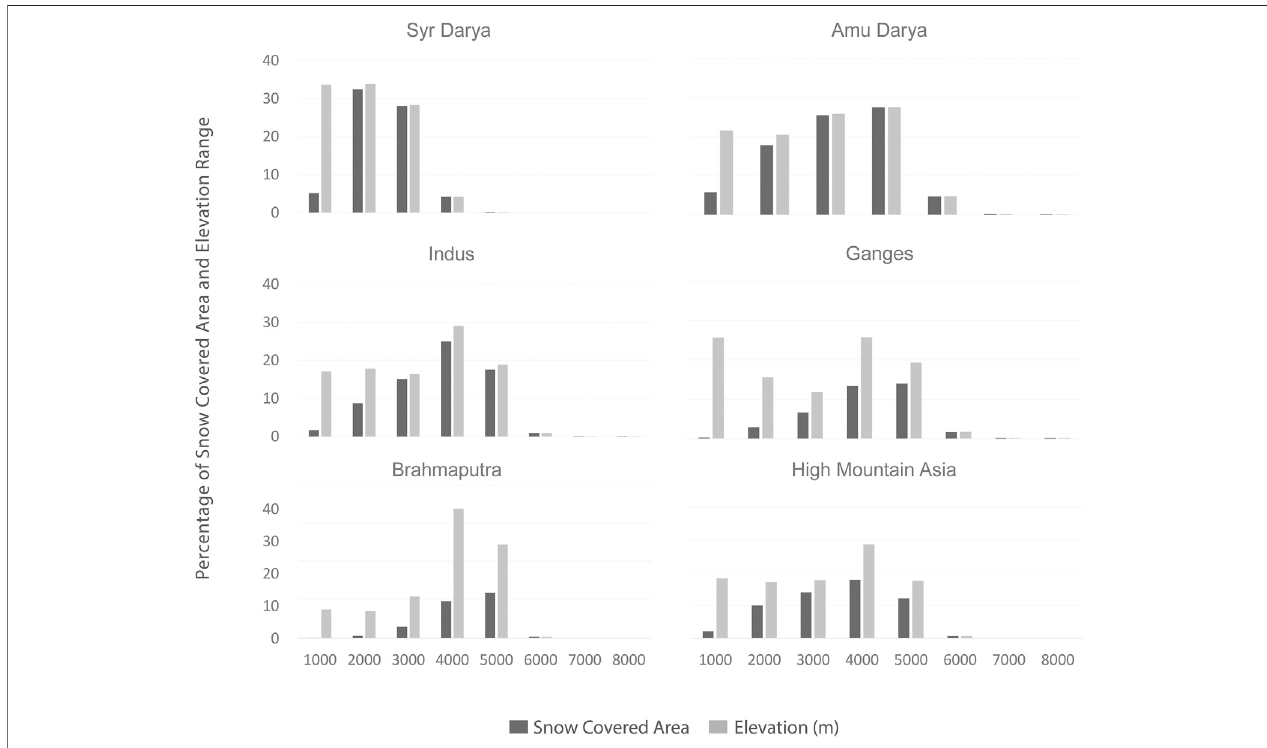
FIGURE 2 | Percentage of elevation ranges and snow-covered area for High Mountain Asia and the fi ve target basins. Elevations are determined using ASTER GDEM V2. For demonstration purposes we used snow-covered area from MODSCAG-STC for the year 2002. Higher elevation bands with indistinct bars are typically <